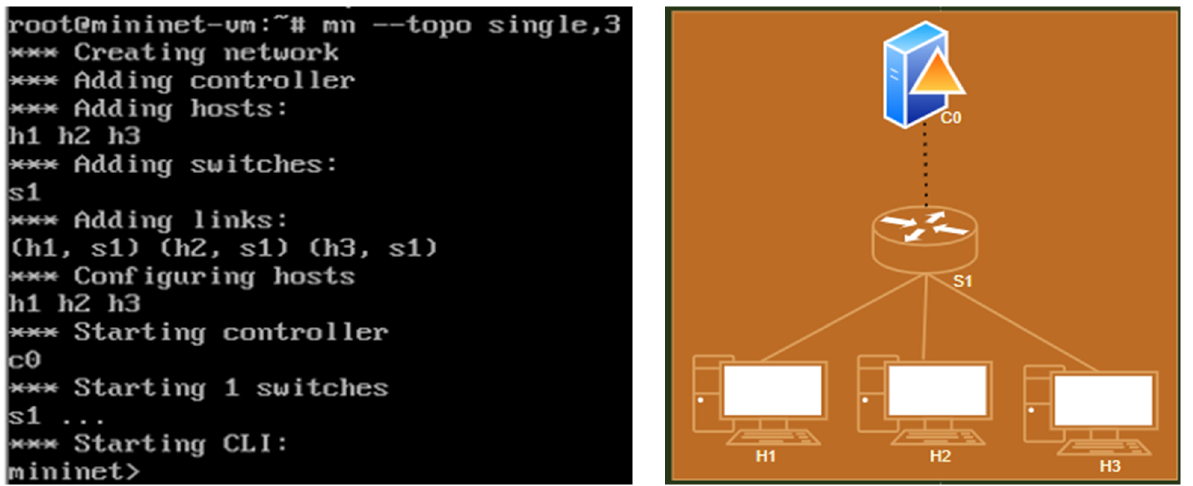
Figure 14. Simple topology Mininet command: sudo mn.